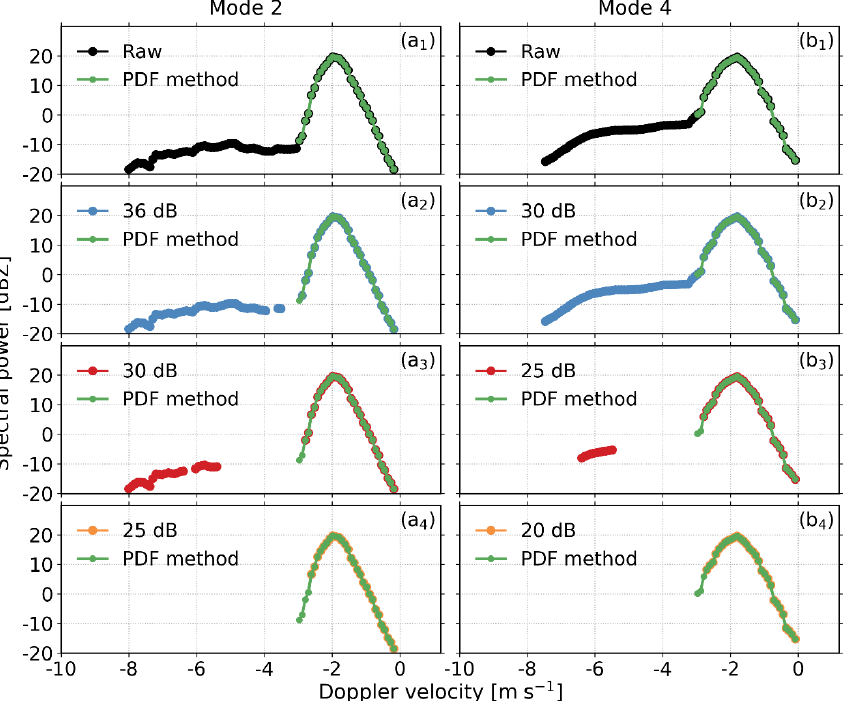
Figure C2. Ku-band Doppler power spectra recorded at (a1–a4) modes 2 and (b1–b4) 4 at 5.01km after the sidelobe mitigation using the threshold method and PDF method on 6 June 2020 at